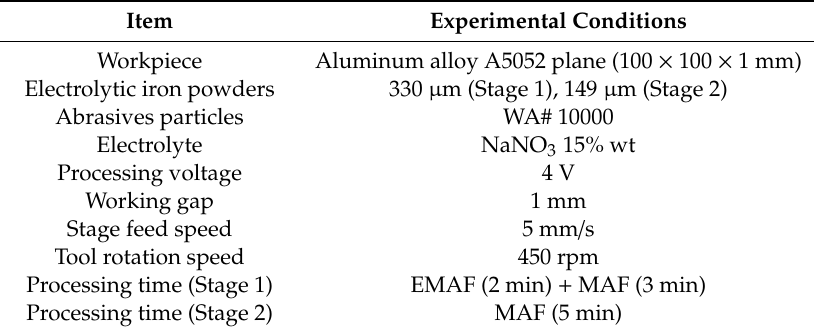
Table 3. EMAF experimental conditions.